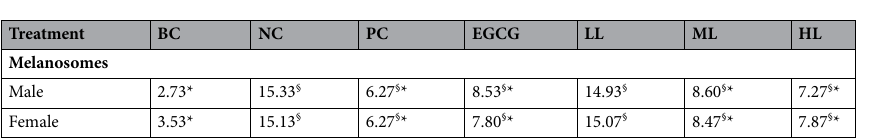
Table 2. Effect of various treatments on UVB-induced formation of melanosomes. § Being significantly different from BC at p < 0.05. *Being significantly different from NC at p <